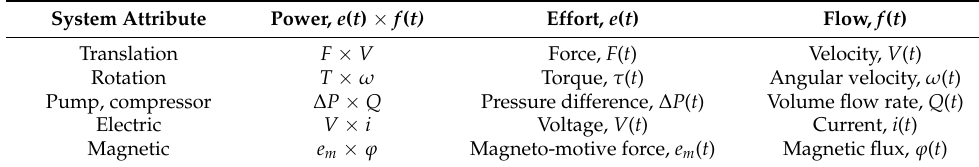
Figure 7. Sine hyperbolic stress expression versus S - N curve from a viewpoint of stress range. Table 2. Power concept in a multi-port product expressed as effort and